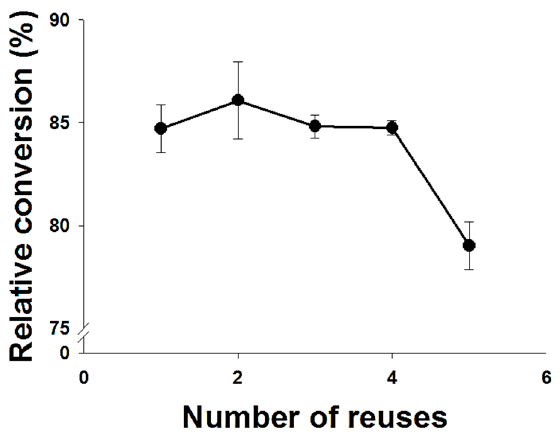
Figure 8. Reusability of Novozyme ® 435 on the synthesis of retinyl laurate. Reusability of Novozyme ® 435 was evaluated under optimized experimental conditions (reaction time of 4.4 h, a reaction temperature of 58 °C, an enzyme amount of 50 mg, and a molar ratio of 1:5).